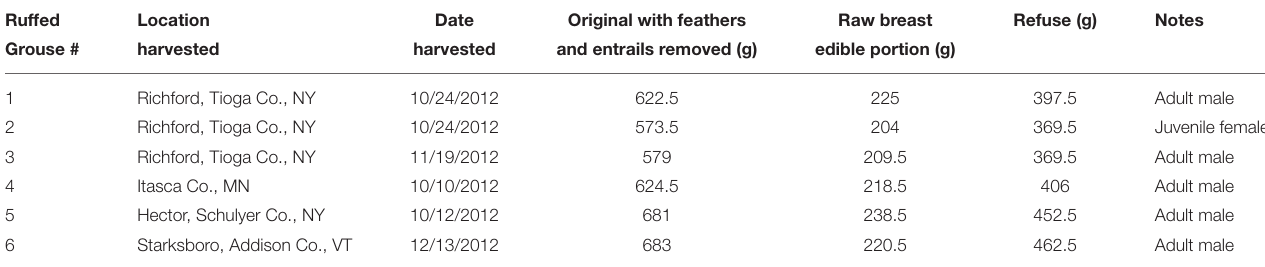
TABLE 1 | Location and dissection data for Ruffed